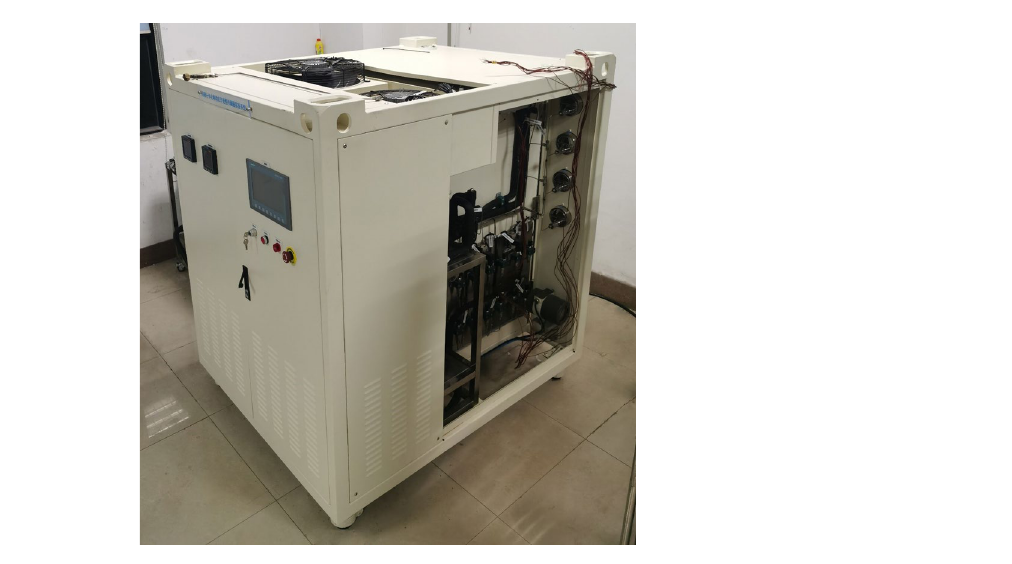
Figure 3. CO 2 transcritical refrigeration experimental